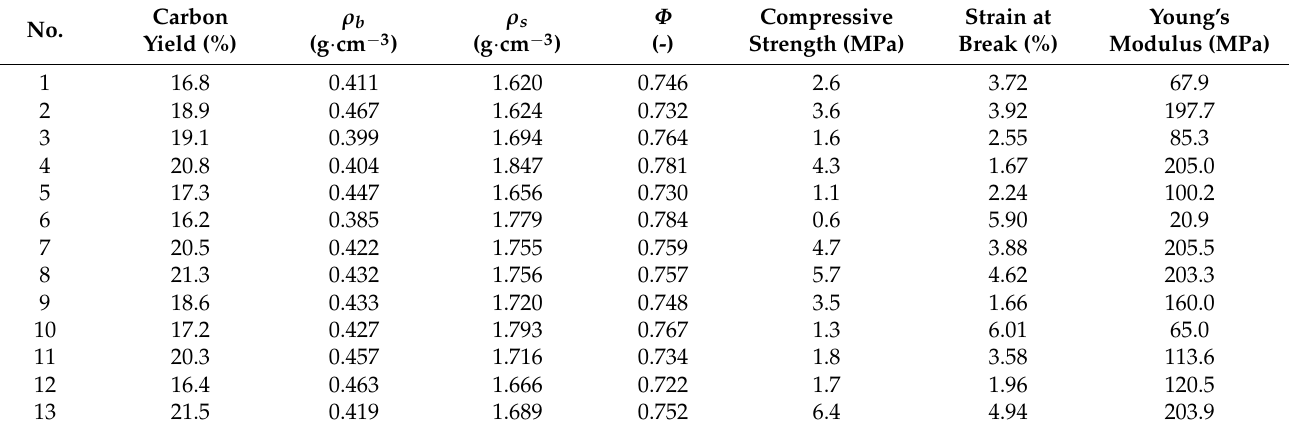
Table 3. The experimental results for the 13 printed carbons based on resins formulated after the mixture